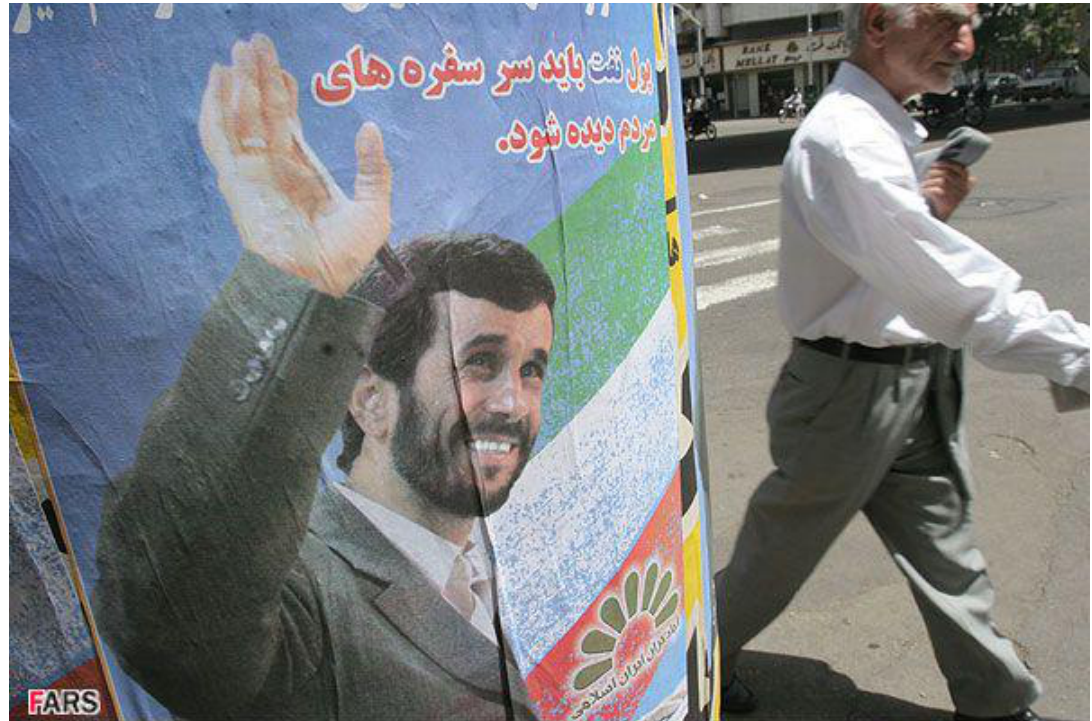
Image 3: Campaign poster for 2005